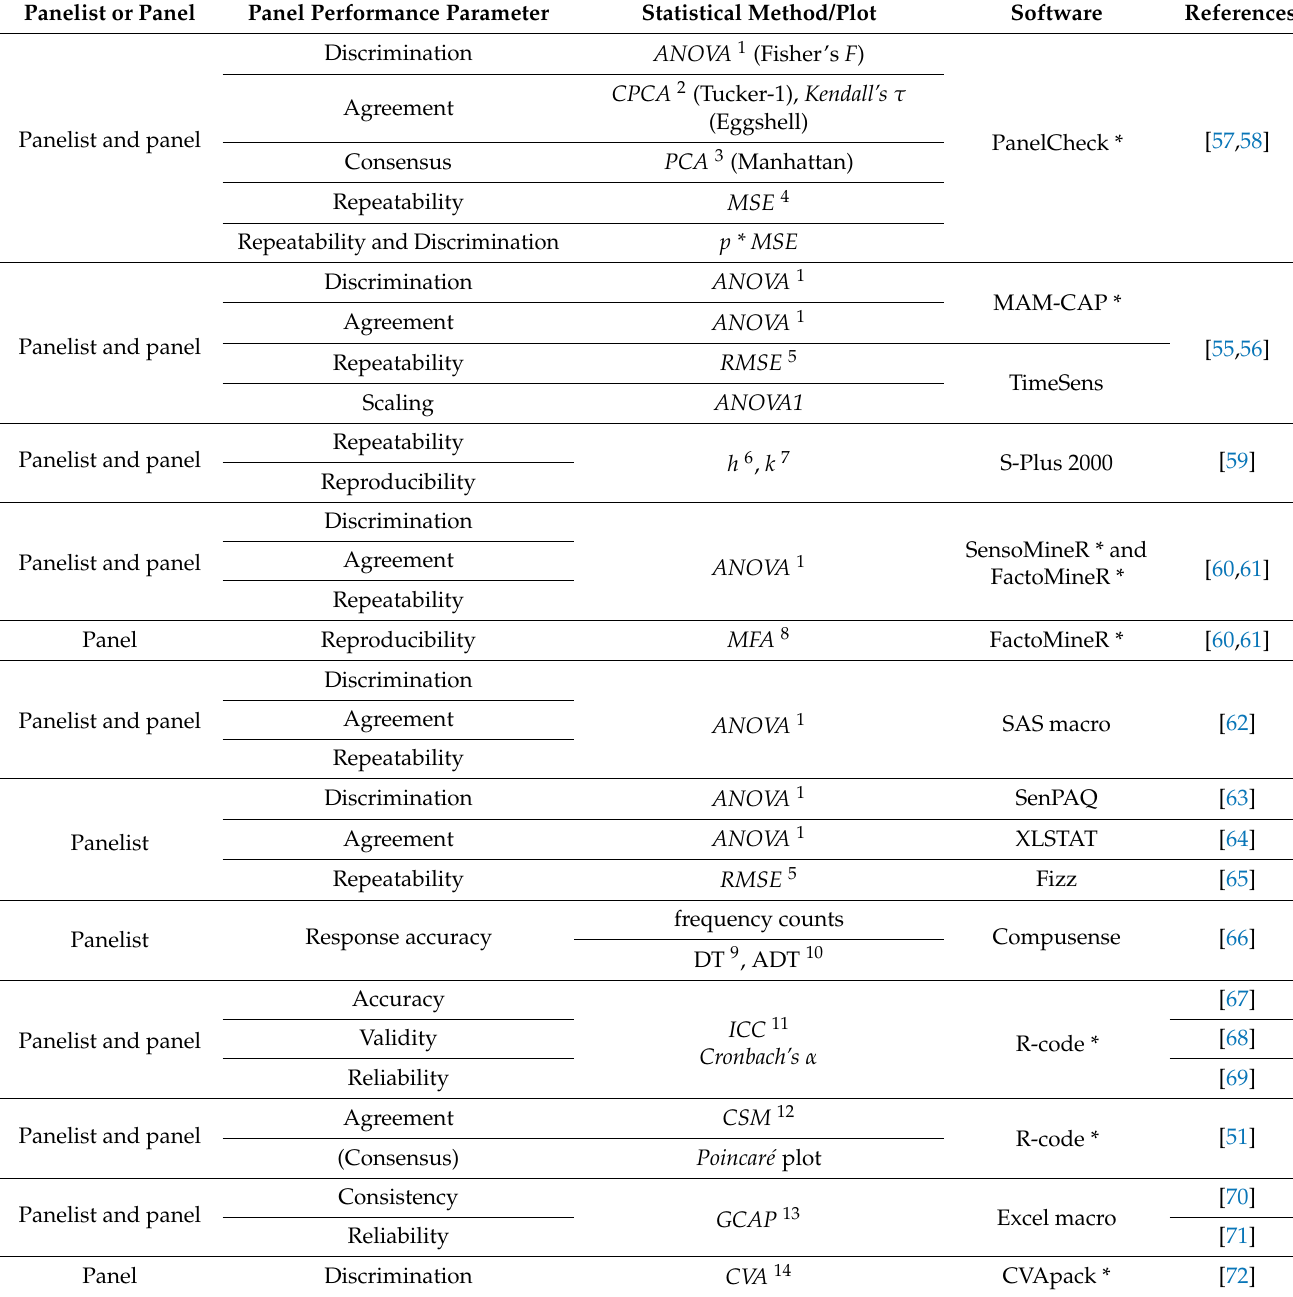
Table 1. Method and software developments in assessor and sensory panel performance evaluation. Panelist or Panel Panel Performance Parameter Statistical